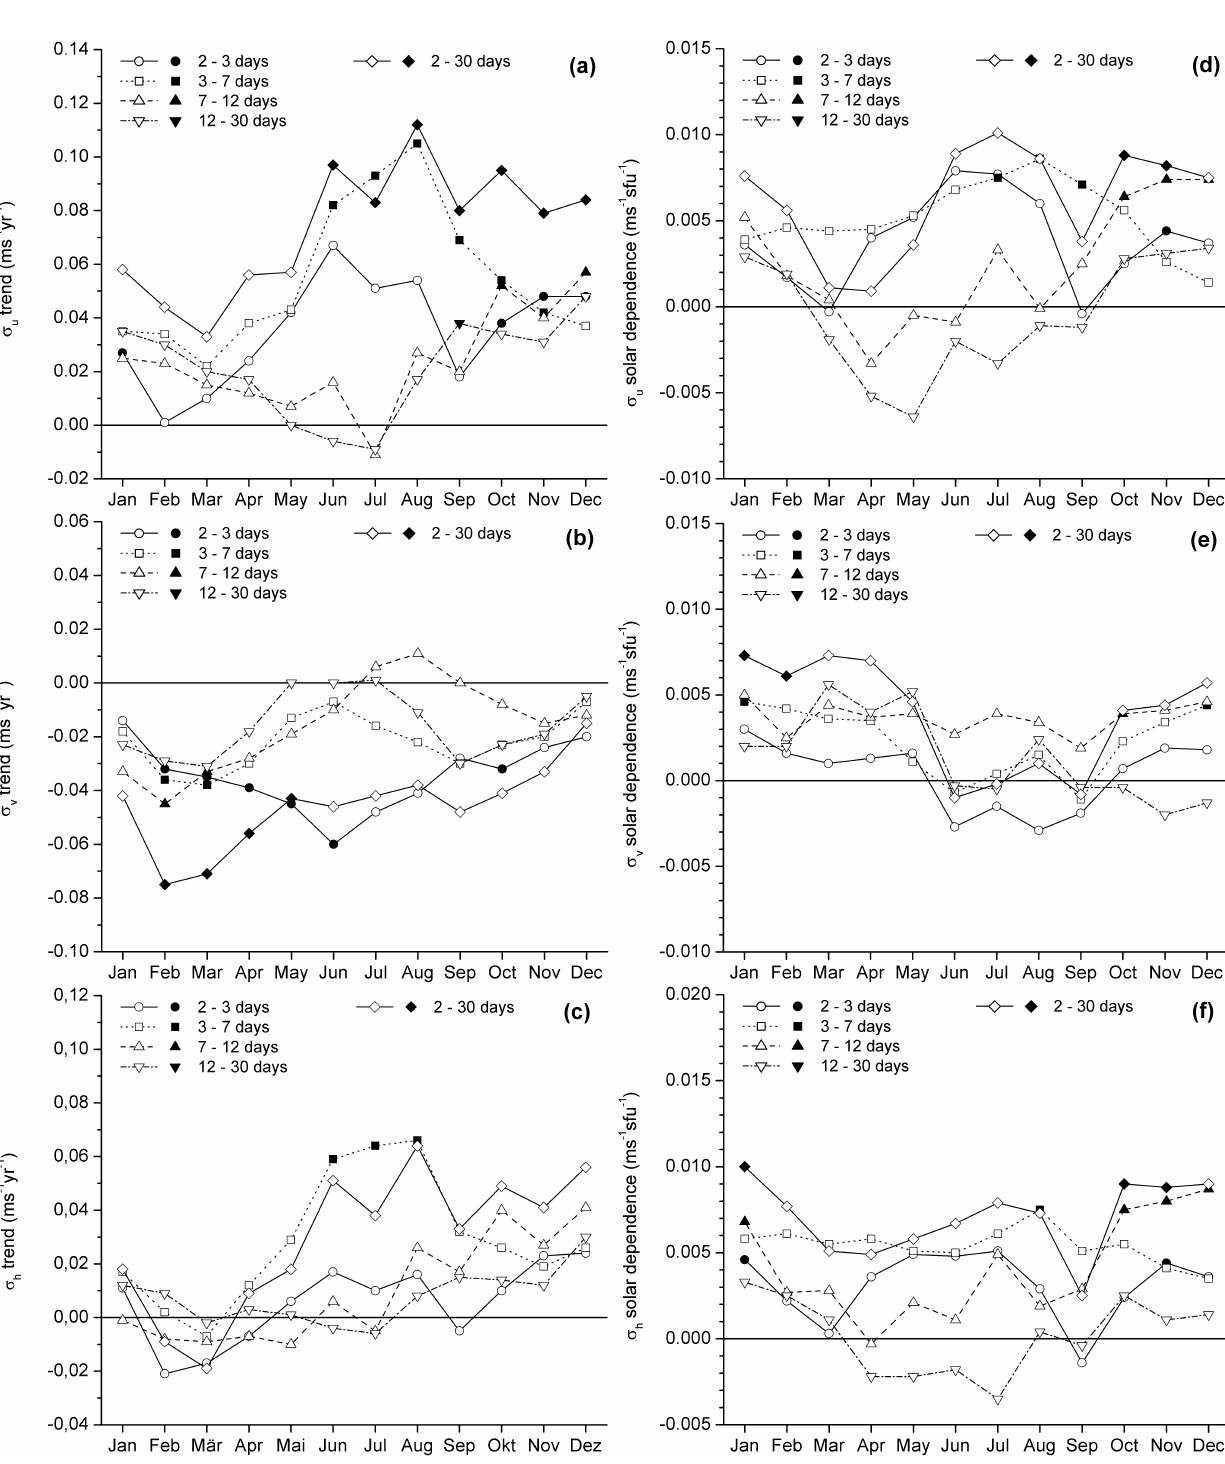
Fig. 5. Trend (left panels) and solar cycle dependence (right panels) coefficients ( A and B from Eq. 2) for the standard deviation of the zonal (upper panels), meridional (middle panels) and total (lower panels) daily mean winds filtered in different period interval, derived from a multiple regression analysis. Solid symbols denote statistically significant correlation according to a